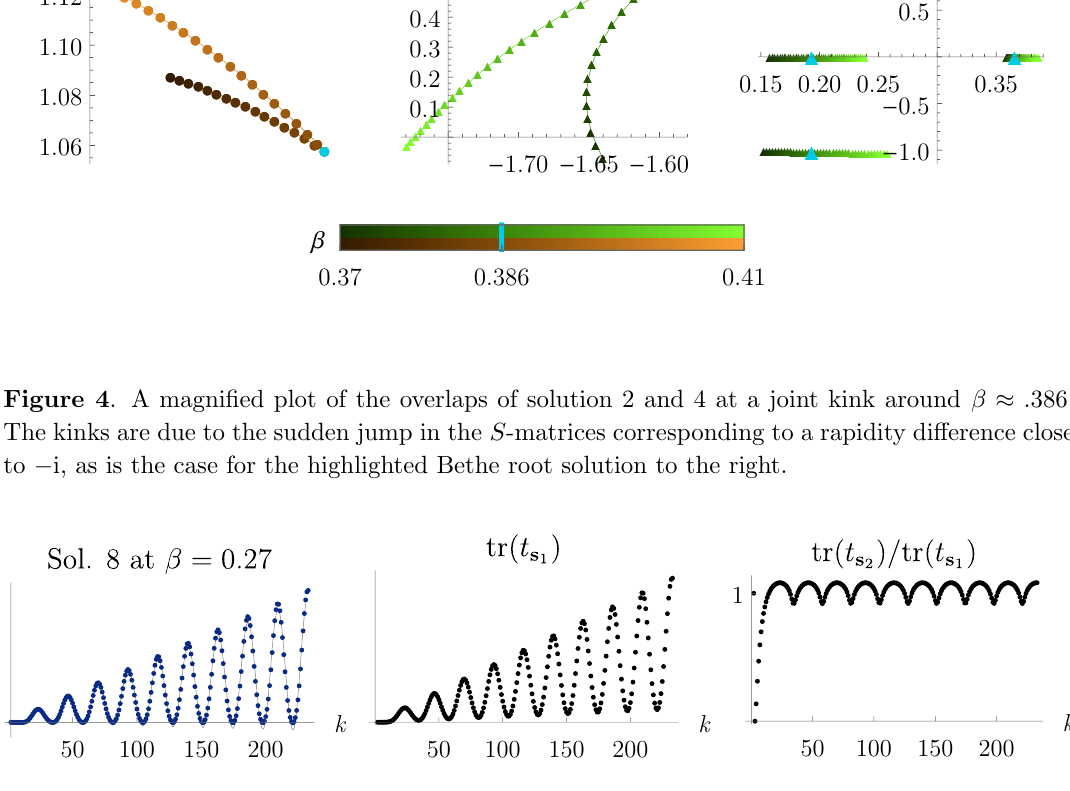
) = tr( t 4 t 4 ), seen in the middle, since di(cid:11)erent 3 1 1